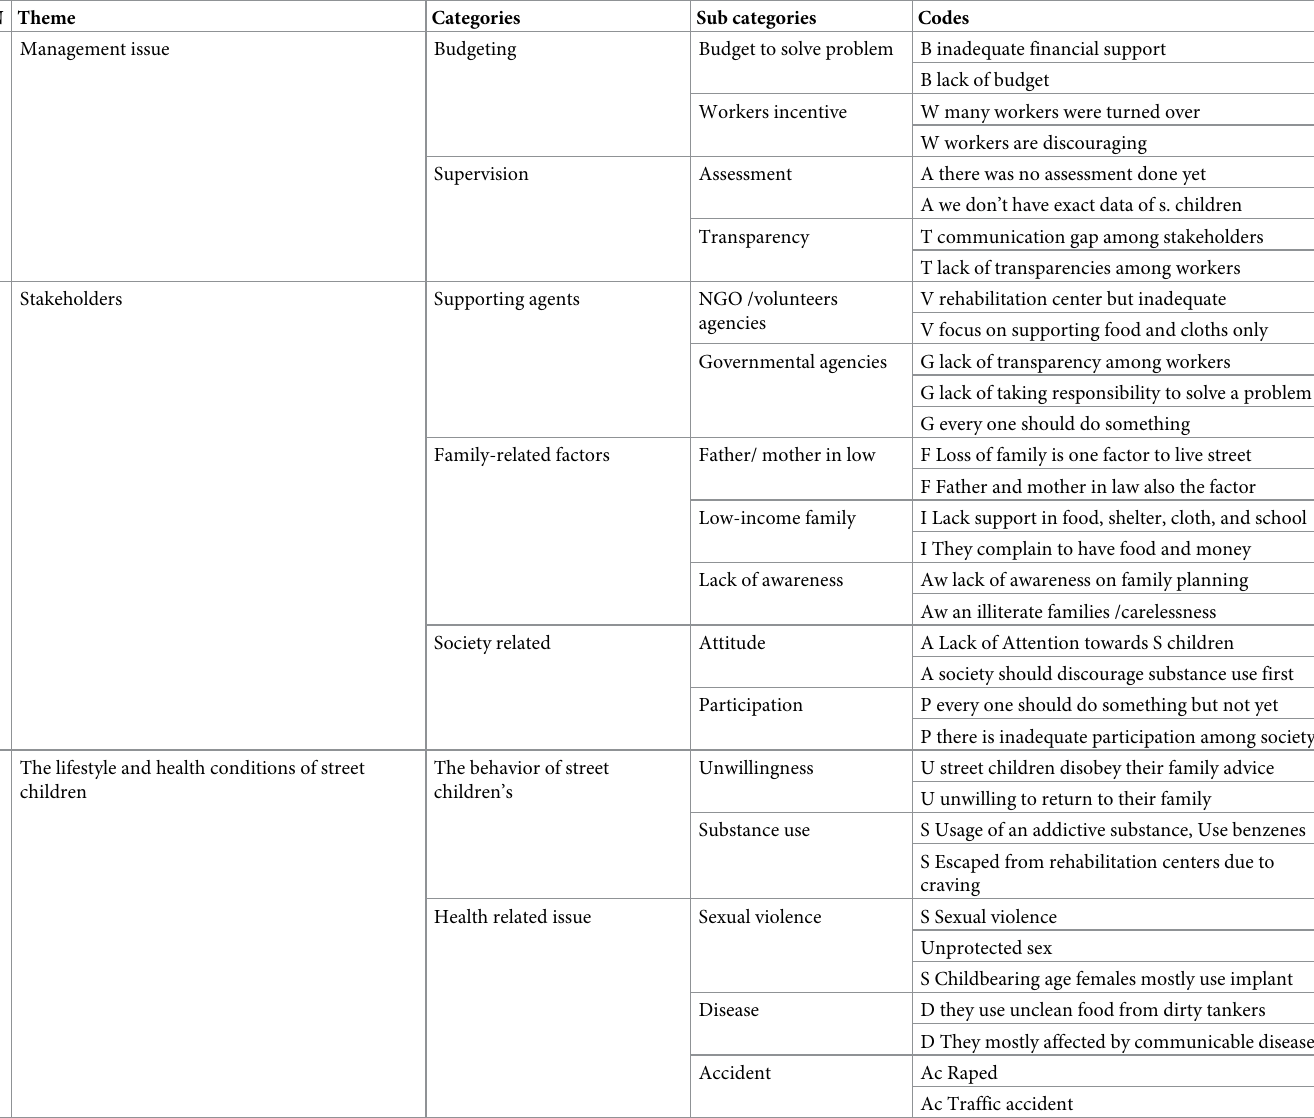
Table 3. Explored reasons forcing street children to live in the street in Harar, eastern Ethiopia,